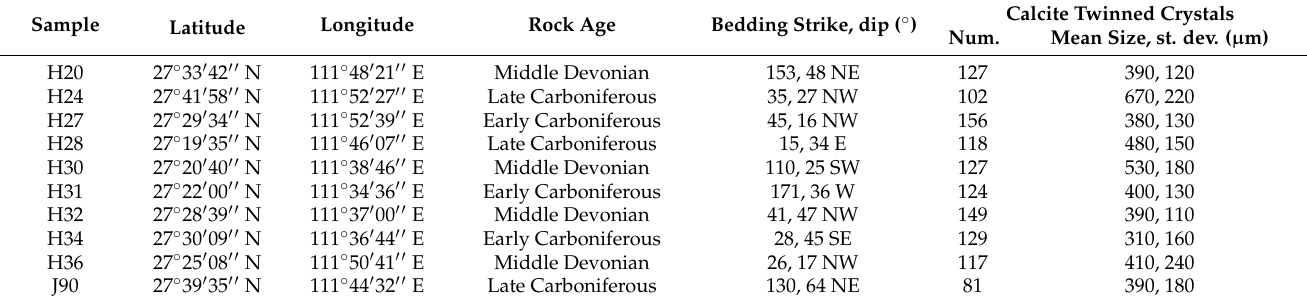
Table 1. A list of limestone samples collected from the Longshan